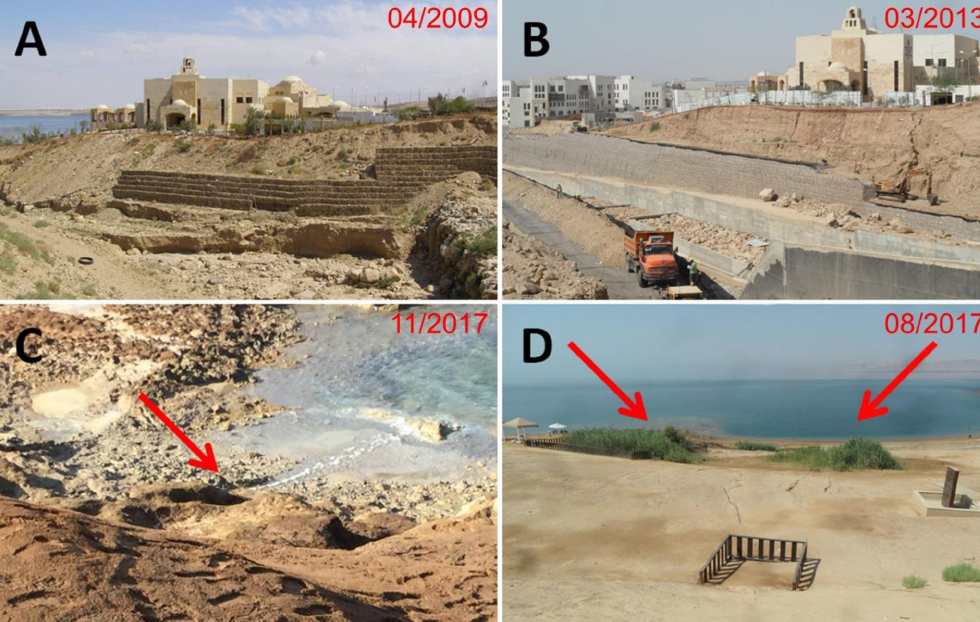
Figure 9. The King Hussein bin Talal convention centre and surrounding areas. (a, b) The river next to the conference centre is entrenching at the same pace as the DS level lowering. Frequent works are needed to stabilize the slopes in the area. (c) Groundwater flowing under the convention centre. (d) When the flow path remains stable and the water is unsaturated with respect to salt, then vegetation can grow.